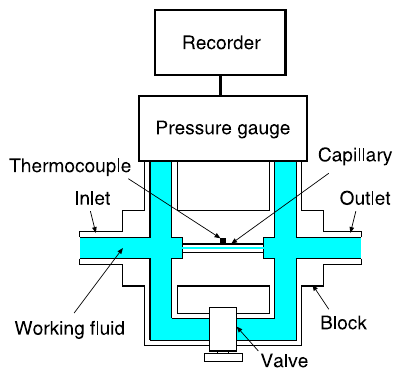
Fig. 1 Schematic diagram of the flowmeter.